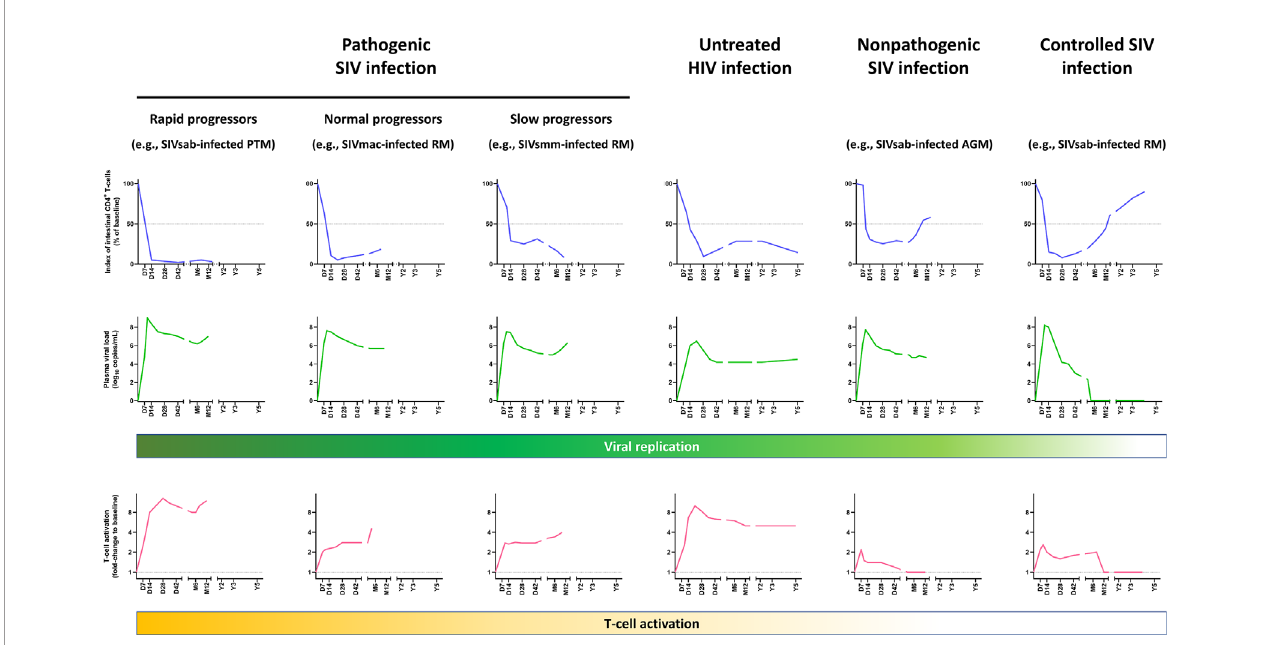
FIGURE 1 | Comparative dynamics of intestinal CD4 + T-cell depletion, plasma viral loads and immune activation/in fl ammation in untreated HIV and SIV infections. Schematic representation of intestinal CD4 + T-cell depletion, viral replication and immune activation is inferred from data reported in references (21, 33, 48, 84 – 91). Longitudinal data are presented, with the X axis representing days (D), months (M) and years (Y) postinfection. The Y axis illustrates the magnitude of lamina propria CD4 + T-cell depletion (upper panels, blue), viral replication (middle panels, green), and the levels of T-cell activation (lower panels, yellow). Intestinal CD4 + T-cell depletion is illustrated as the index of lamina propria CD4 + T cells (i.e., percentage of CD4 + T cell fraction within the CD3 + T cell population, divided by this percentage at baseline). Viral replication is represented as plasma viral loads. From the plethora of biomarkers of immune activation/in fl ammation, we selected the fold-change of HLA-DR + CD8 + T cells in SIV-infected NHPs, compared to the baseline preinfection levels, except for persons living with HIV, for which the fold- changes of HLA-DR + CD38 + CD8 + T cells were used. Note that in other primate models of rapid progressors, T-cell activation might be more blunted (92). AGM, African green monkeys; PTM, Pigtailed macaques; RM, Rhesus